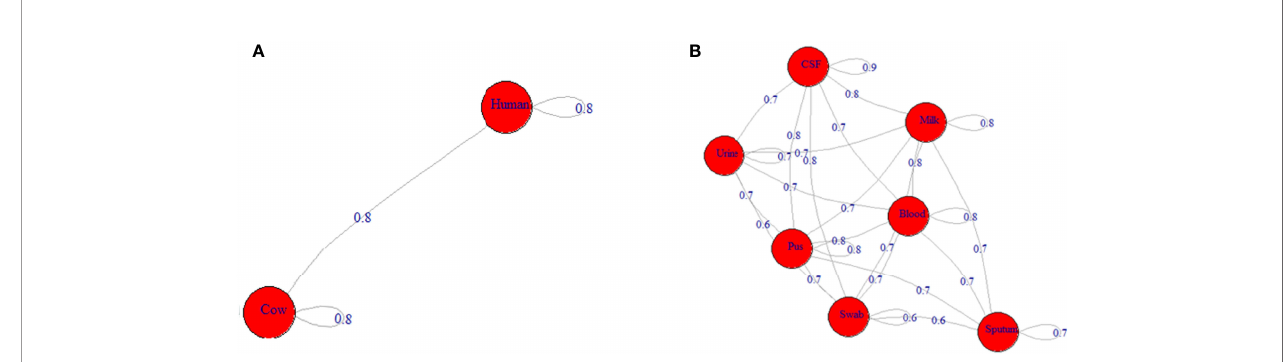
FIGURE 5 | Network depicting the differences among ST239-MRSA strains based on both genotypes and toxin gene pro fi le. (A) The average distance among strains from humans and cows. (B) The average distance among strains from various samples.